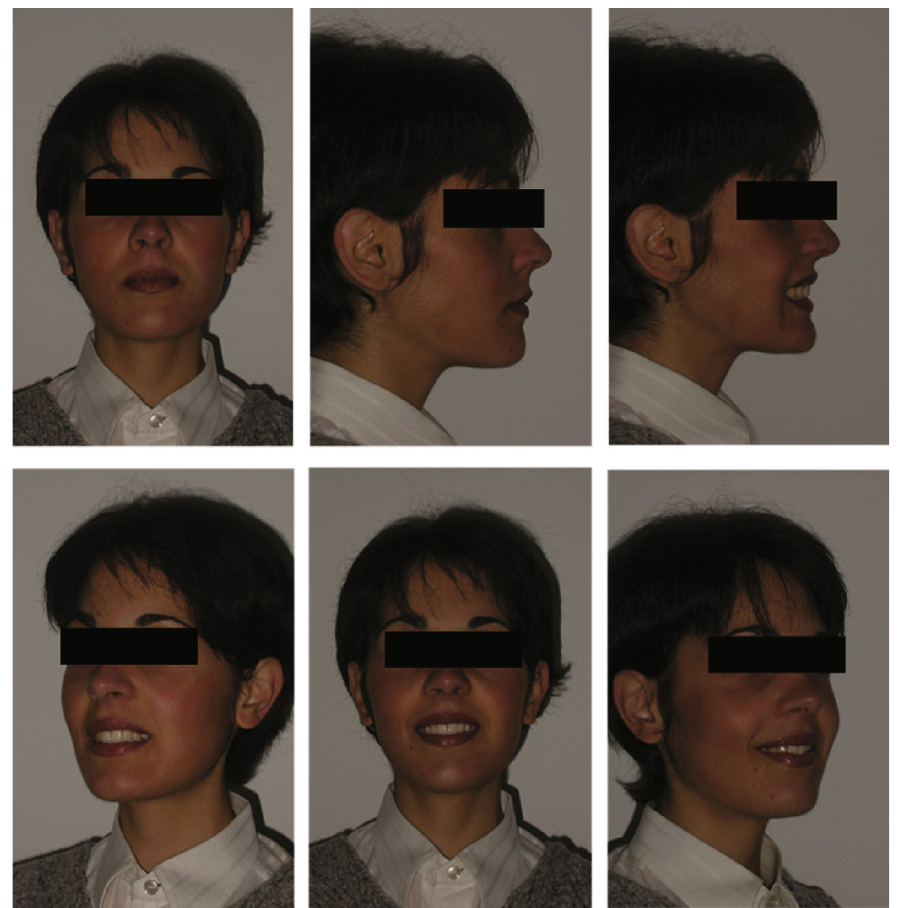
Figure 15: 5-year follow-up extraoral